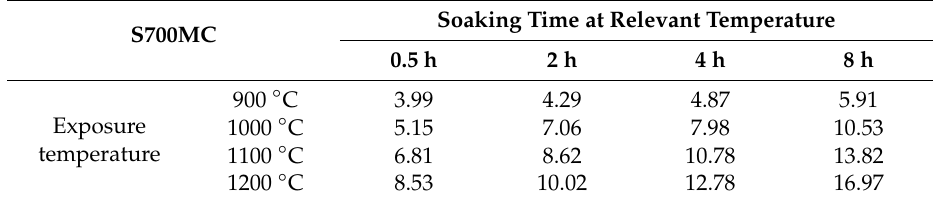
Figure 2. Results of EBSD analysis of grain size determination after 2 h at exposure temperature: ( a ) 900 °C; ( b ) 1000 °C; ( c ) 1100 °C; and ( d ) 1200 °C. Table 2. EBSD grain size analysis results expressed as mean grain size ( µ m) for the indicated exposure temperatures and soaking times on these temperatures.